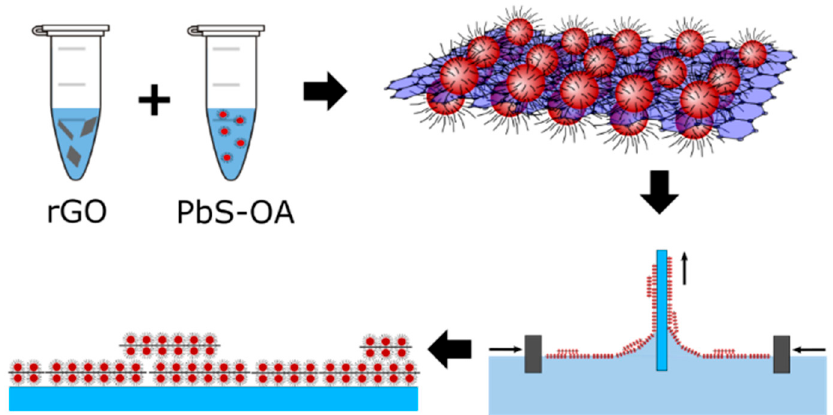
Figure 1. Schematic presentation of the preparation of thin rGO–PbS films.